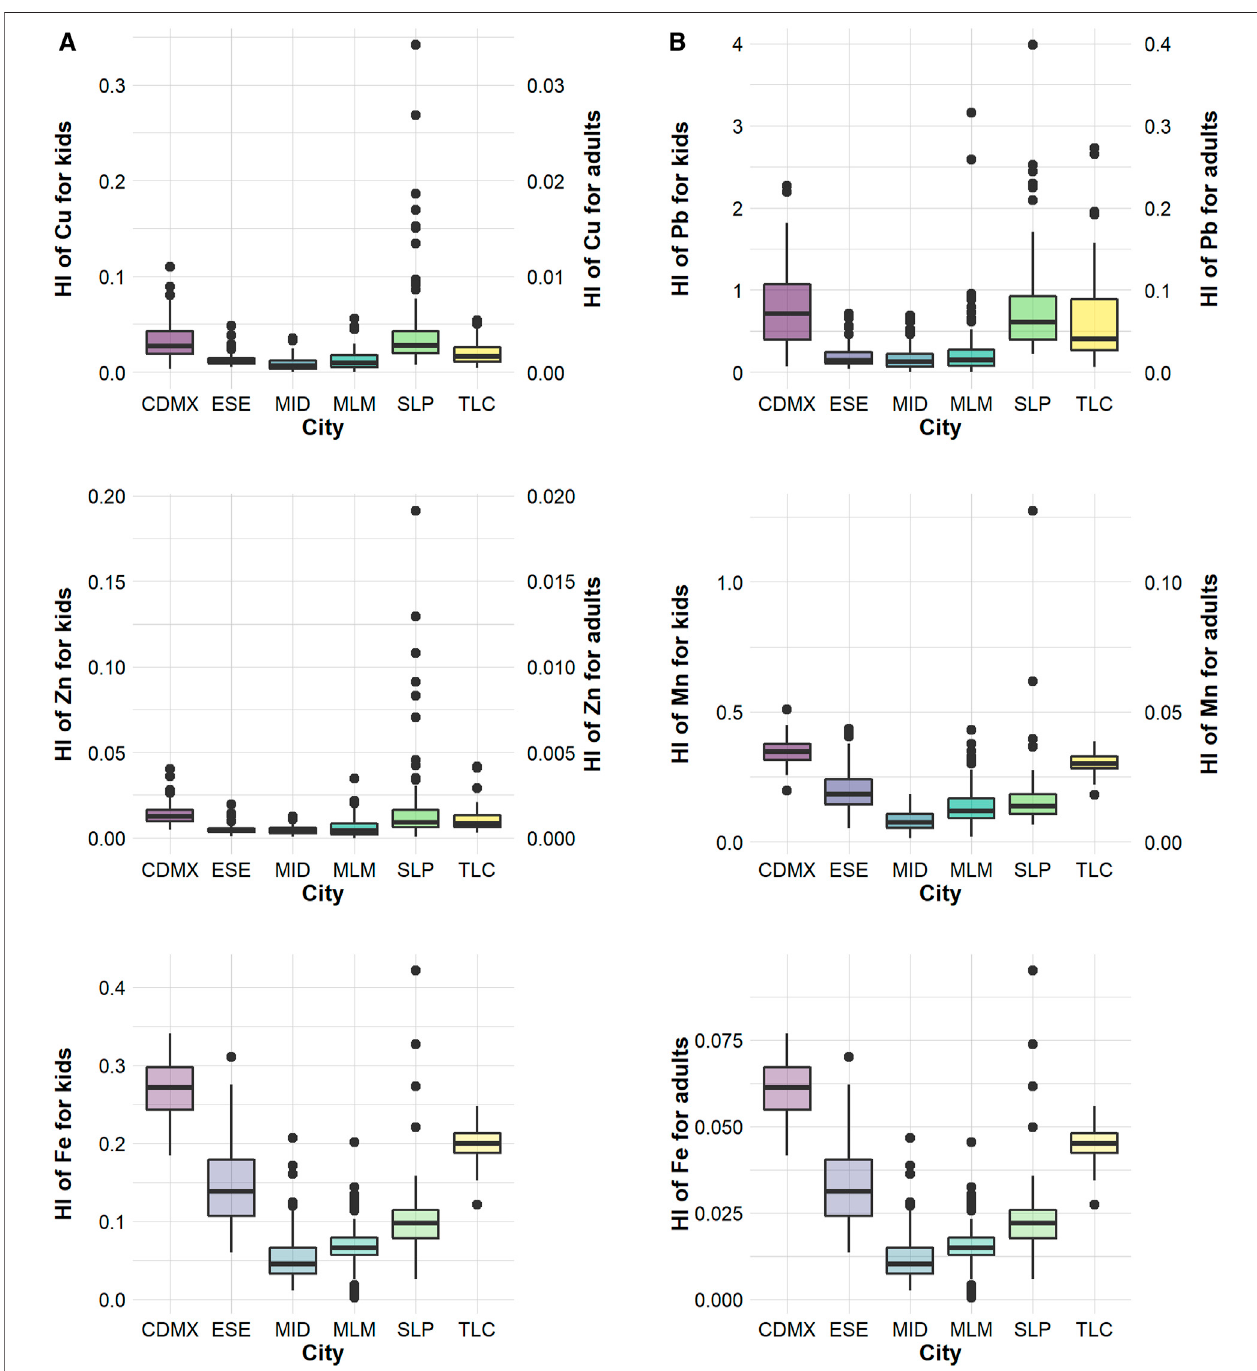
FIGURE 4 | Box plots of the human health risk indices (HI) for children (A) and adults (B) , of each heavy metal for Mexican cities. CDMX: Mexico City, ESE: Ensenada, MID: Mérida, MLM: Morelia, SLP: San Luis Potosí, TCL: Toluca.